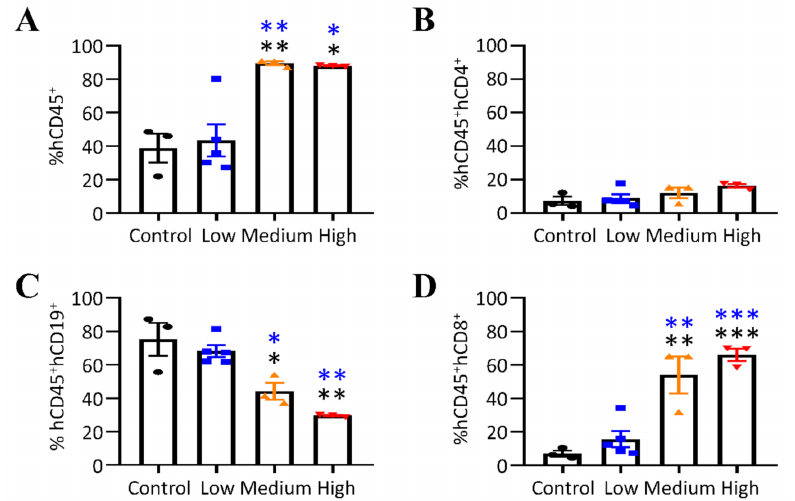
Figure 4. Splenic lymphocytes were analyzed in EBV-infected humanized mice. ( A – D ) The frequency of ( A ) hCD45 + , ( B ) hCD45 + hCD4 + , ( C ) hCD45 + hCD19 + , and ( D ) hCD45 + hCD8 + cells in spleens at the study endpoint. Data points represent mean ± SEM of uninfected control mice ( n = 3), low ( n = 5), medium ( n = 3), high ( n = 3) doses (GRUs) of Akata-EBV-GFP infected mice, * p < 0.05, ** p < 0.01, *** p <